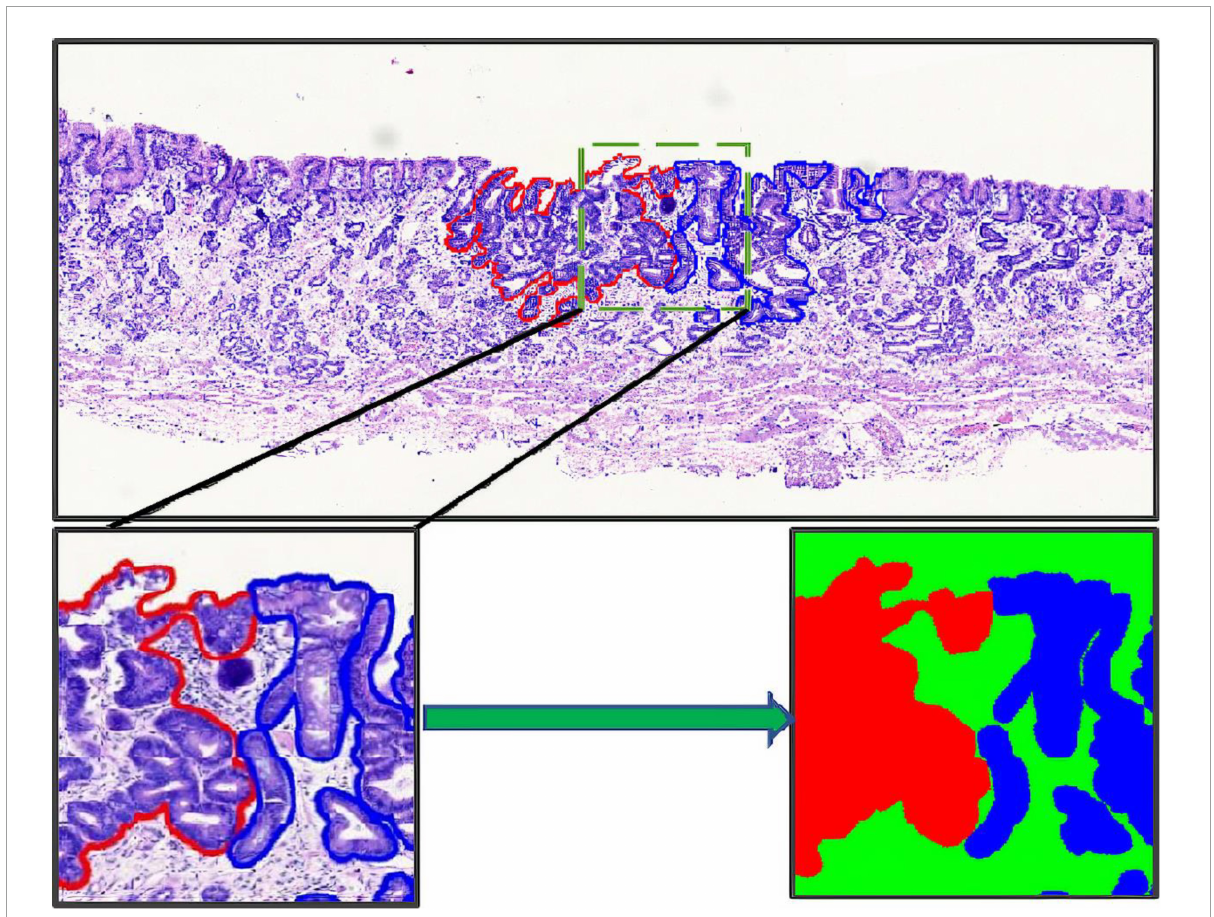
FIGURE3 Whole slide image annotation. (Above and lower left) Endoscopic submucosal dissection specimen with cancerous regions outlined in red, and intestinal metaplasia regions in blue. (Lower right) Corresponding masks for using in deep learning.